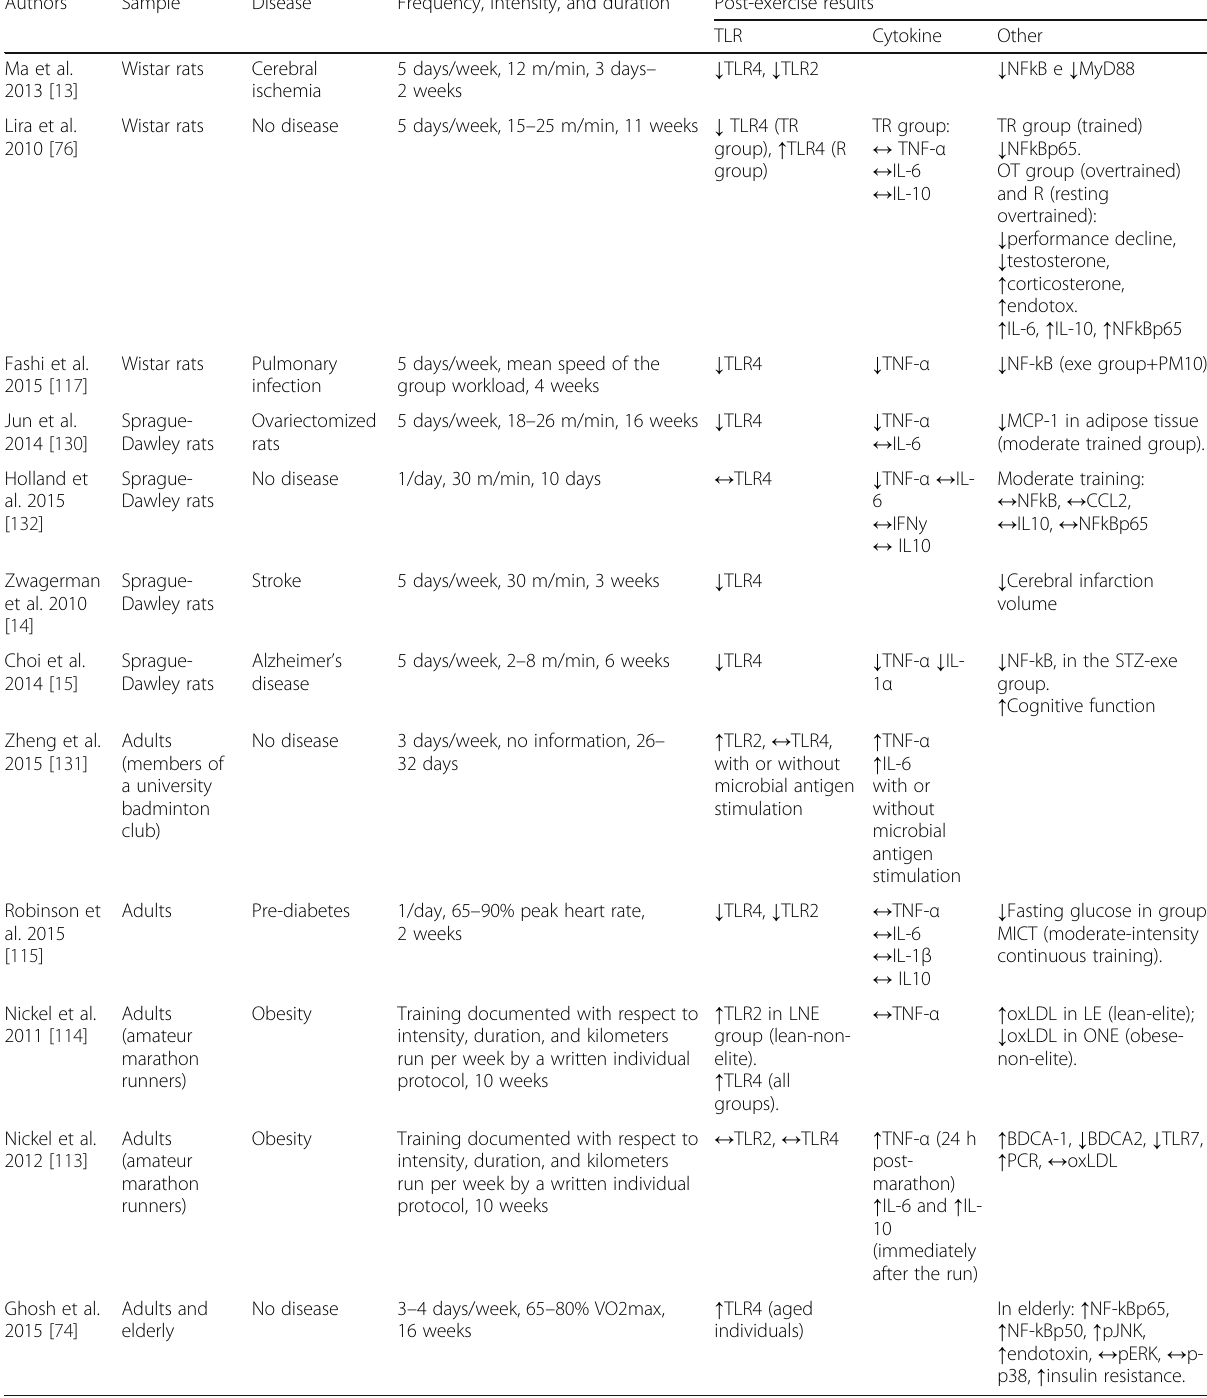
Table 6 Modulation of TLR2 and TLR4 after chronic aerobic exercise